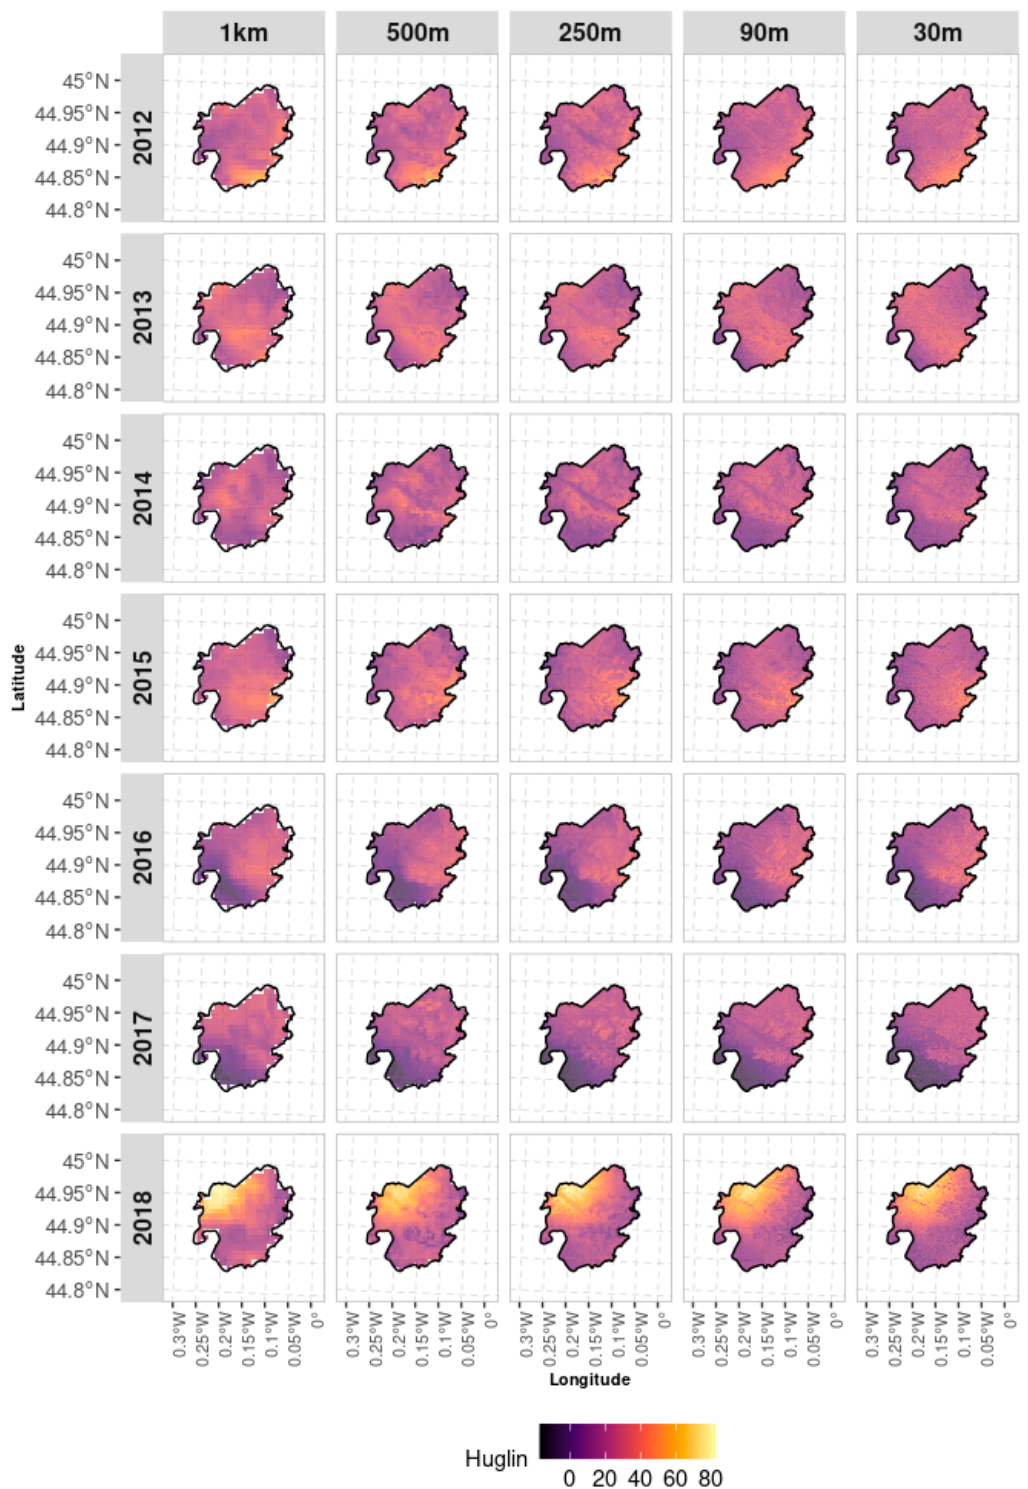
Figure A2. Spatial distribution of differences in the Huglin bioclimatic index calculated from daily land surface temperature (M*11A1) minus that calculated from the 8-day land surface temperature (M*D11A2) from 2012–2018 and gridded at different spatial resolutions.